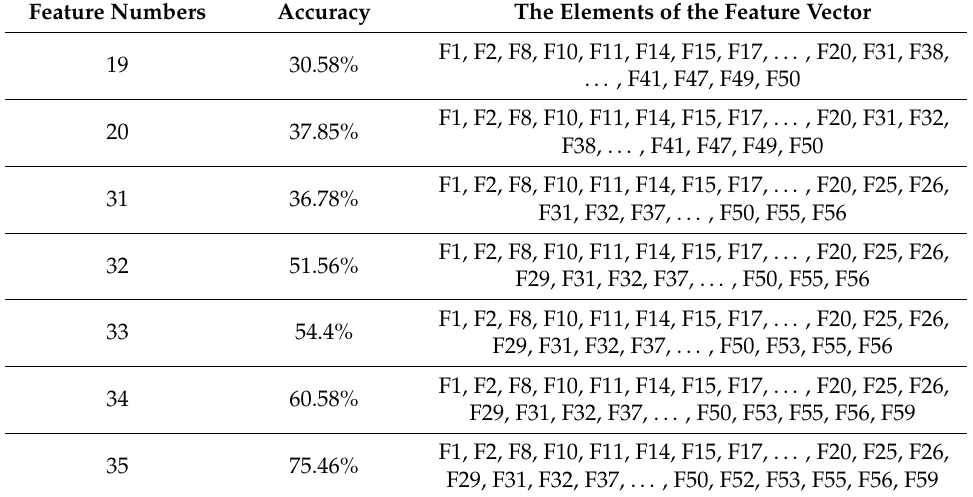
Table 4. Result of